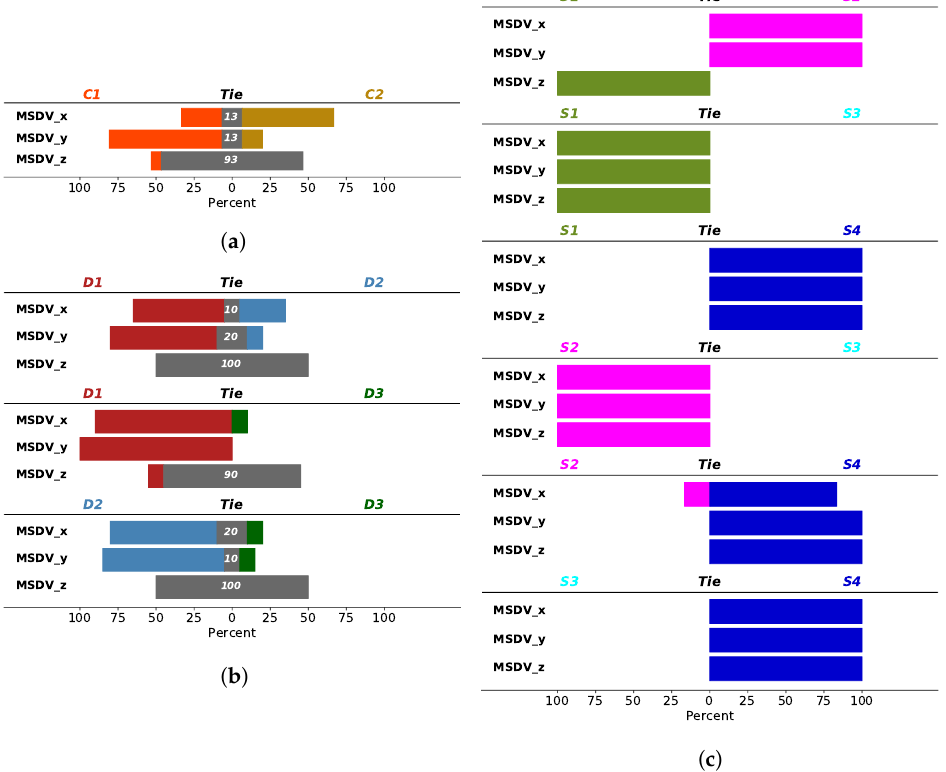
Figure 8. Comparison between drivers, cars and sections when MSDV x , MSDV y , MSDV z are considered. The percentages of situations where car i exceeds car j ( a ); driver i exceeds driver j ( b ); and section i exceeds section j ( c ) for each particular